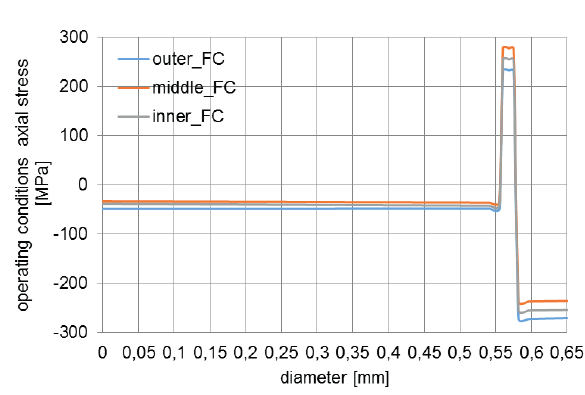
Figure 23: Total axial stress distributions in the assembly: mSOFC stack, sealants, manifolds along the vertical centerlines of each layer (anode, electrolyte, cathode) for the bottom points of fuel cell.